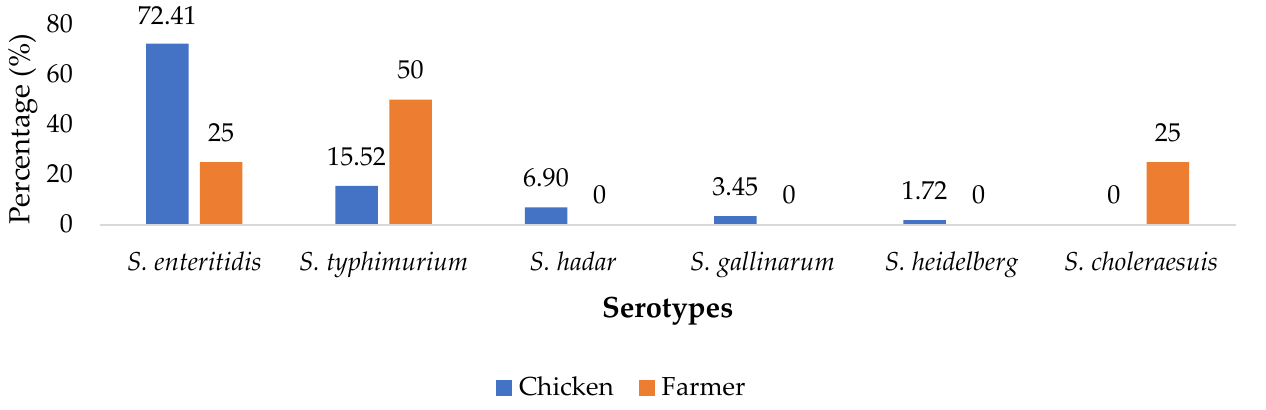
Figure 1. Frequency of different SE serotypes recovered from chickens and farmers. 2.2. Susceptibility of SE Isolates to Antimicrobials Most chicken isolates were susceptible to imipenem (220/232), and none were suscep- tible to tetracycline (0/232) (Table 2). Similarly, breeders’ isolates indicated frequent sus- ceptibility to imipenem (12/16) and no susceptibility to tetracycline (0/16), cotrimoxazole (0/16), cefepim (0/16) or ciprofloxacin (0/16). It was noticed that chickens and breeders’ isolates had closely related antimicrobial susceptibility profiles. All isolates collected from both chicken and breeders were resistant to tetracycline; a high resistance prevalence was also observed for cefepim (228/232 and 16/16, respectively), cefoxitin (216/232 and 12/16, respectively), ciprofloxacin (208/232 and 16/16, respectively), nalidixic acid (204/232 and 16/16, respectively) and cotrimoxazole (208/232 and 16/16, respectively). Resistance to Red values = highest percentages; blue values = lowest percentages. ceftiofur was high on chicken isolates. The susceptibility profile of the chicken isolates revealed a mean resistance to 10.60 ± 0.34 of the antibiotics tested. Figure 2 presents the serotypes’ mean range resistance.